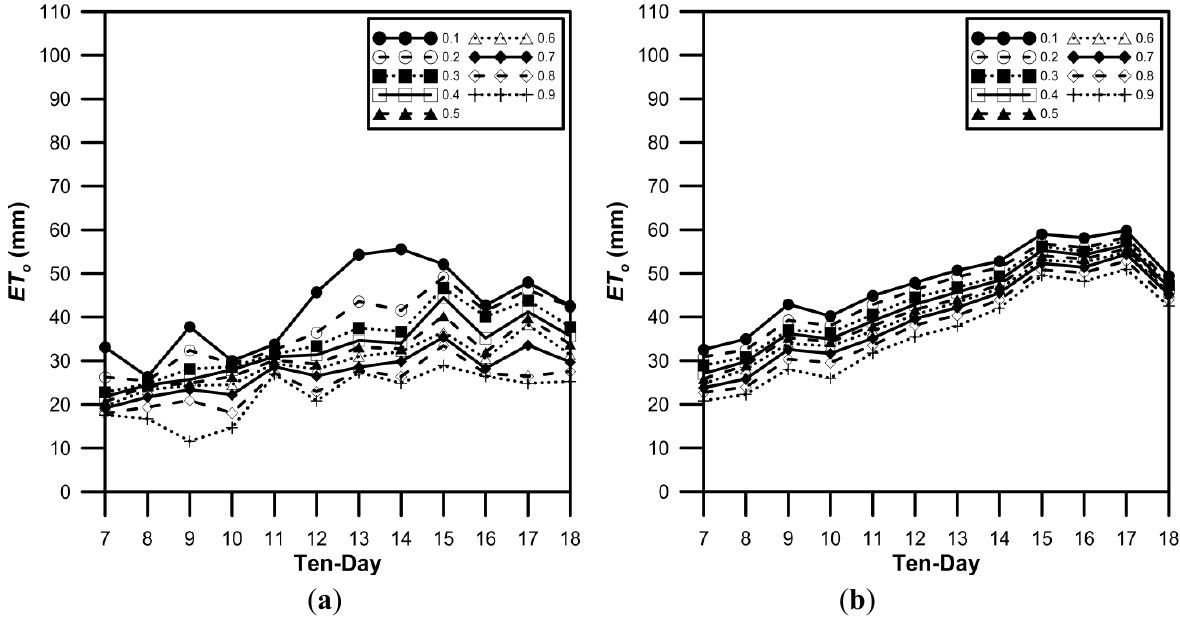
Figure 9. Exceedance probability distribution of evapotranspiration at each ten-day during the first cropping season. ( a ) present (2004–2011); ( b ) future (2046–2065).